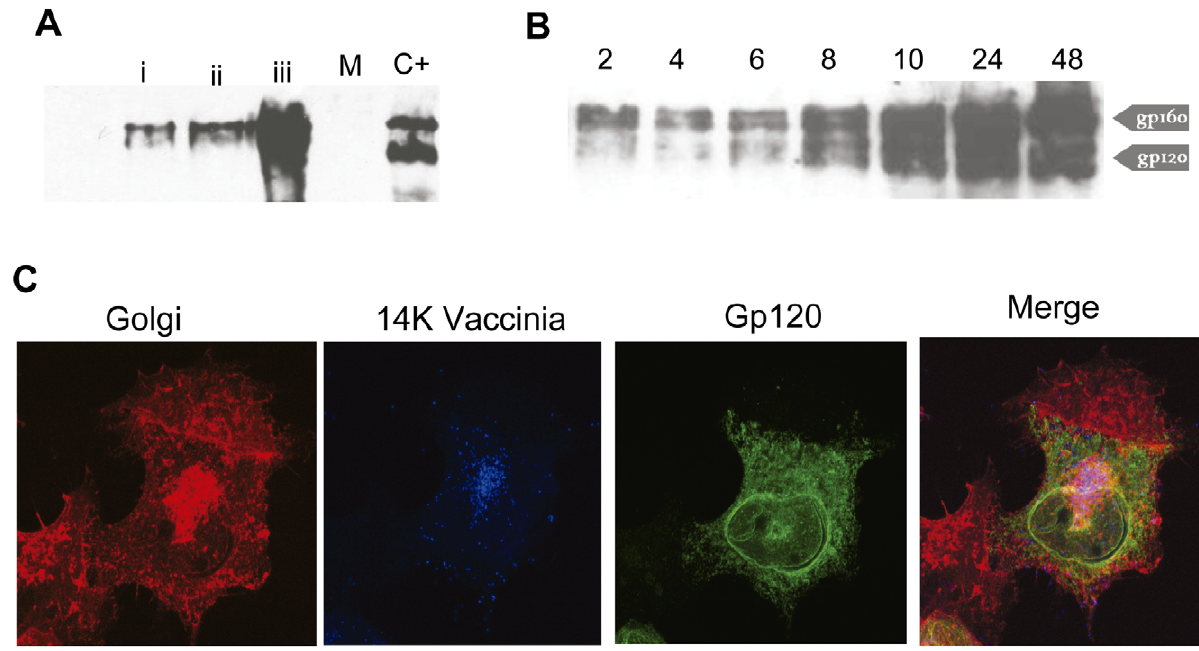
Figure 1. Characterization of the DNA and VVEnvBF vectors generated. A ) The expression of Env was visualized by Western Blot in cell extracts obtained 48 hrs post-transfection of 293-T cells with p env BF or p empty plasmids. Lanes i to iii were loaded with 5, 10 and 20 m g of total protein. Mock transfected cells (M) and cell extracts infected with the VVEnvB virus (C + ) were employed as negative and positive controls. B ) i- Time- course expression of EnvBF after infection of BSC-40 cells. At the indicated hours post-infection Env was detected by WB in pellet samples of infected cells at 5 PFU/cell. C ) Immunofluorescence analysis of EnvBF expression after VVEnvBF infection (0.1 PFU/cell) of HeLa cells. After 18 hrs p.i., cells were fixed, permeabilized, and incubated with polyclonal anti-Env antibody to show Env (green), with C3 monoclonal antibody against 14 Kda VV protein (blue) or with antibody against the wheat germ antigen, to show Golgi (red). To the right is the colour merging.